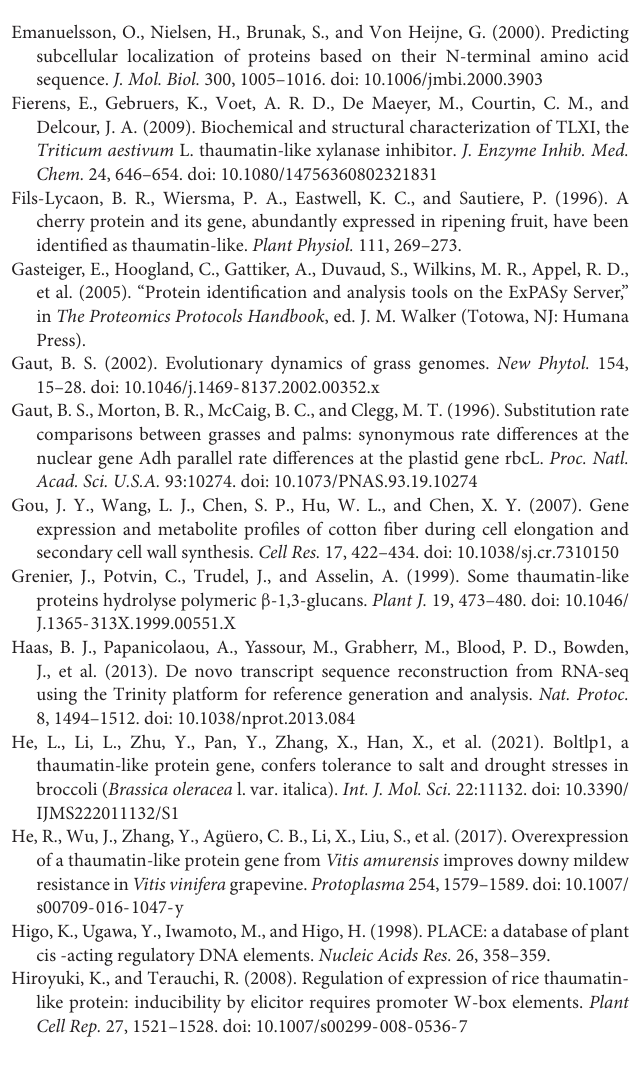
Supplementary Figure 1 | Multiple sequence alignment of 222 Thaumatin-like proteins (TLPs) of B. distachyon, O. sativa, S. bicolor , T. aestivum, and Z. mays . Conserved cysteine residues are marked with an asterisk. The red dot denotes the REDDD motif. The FF hydrophobic motif is highlighted with a green triangle. The thaumatin signature motif, conserved domain, and amino acids forming the bottom of the acidic cleft are marked with sky blue, red, and brown lines, respectively. Supplementary Figure 2 | Intron/exon organization and conserved motifs of TLPs of B. distachyon , O. sativa , S. bicolor, T. aestivum, and Z. mays